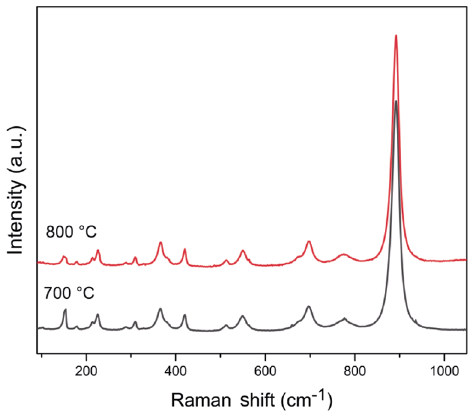
Fig. 5 Absorbance spectra of the NiWO 4 annealing at 700 and 800 ℃ /2 h.